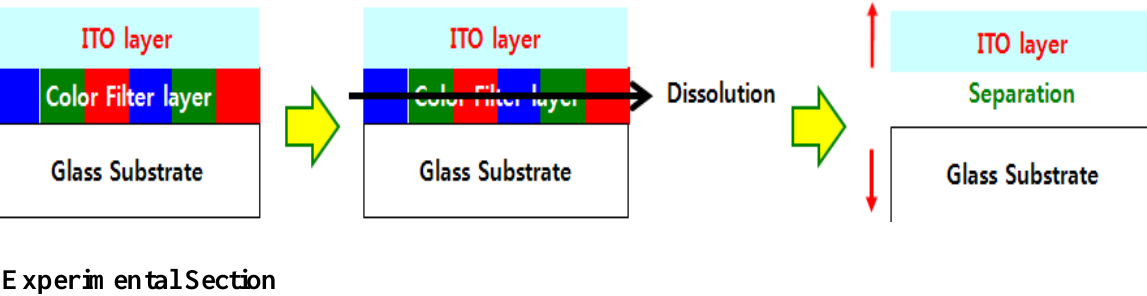
Figure 1. Lift-off method for recovering indium-tin-oxide (ITO) as nanoparticles from glass substrate of thin film transistor-liquid crystal display (TFT-LCD)